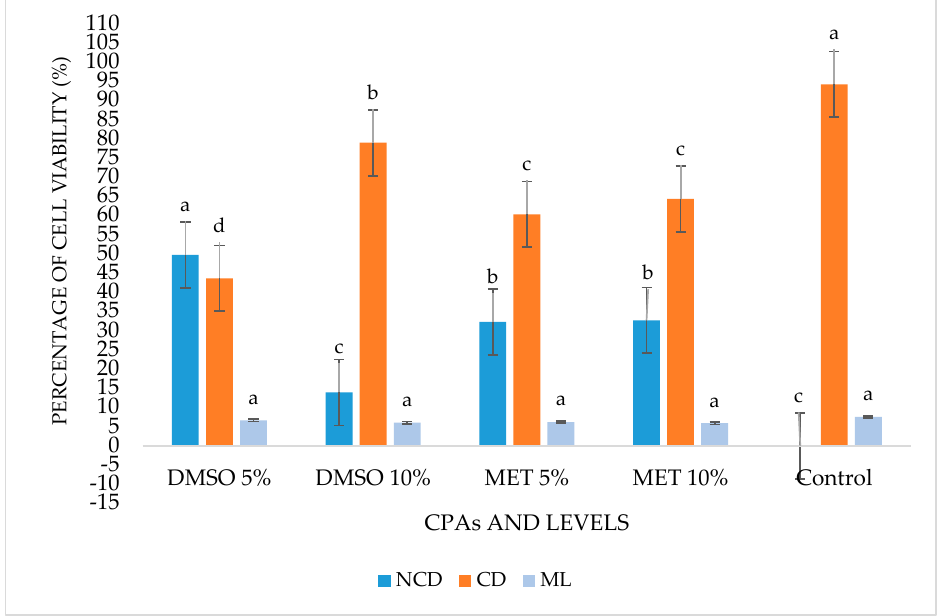
Figure 3. Percentage of cell viability of Scenedesmus sp. on the fifth day after thawing. No cell damage (NCD), with cell damage (CD) and marked lesions (ML) of the evaluated treatments. Different letters for the three criteria indicate significant differences ( p < 0.05).